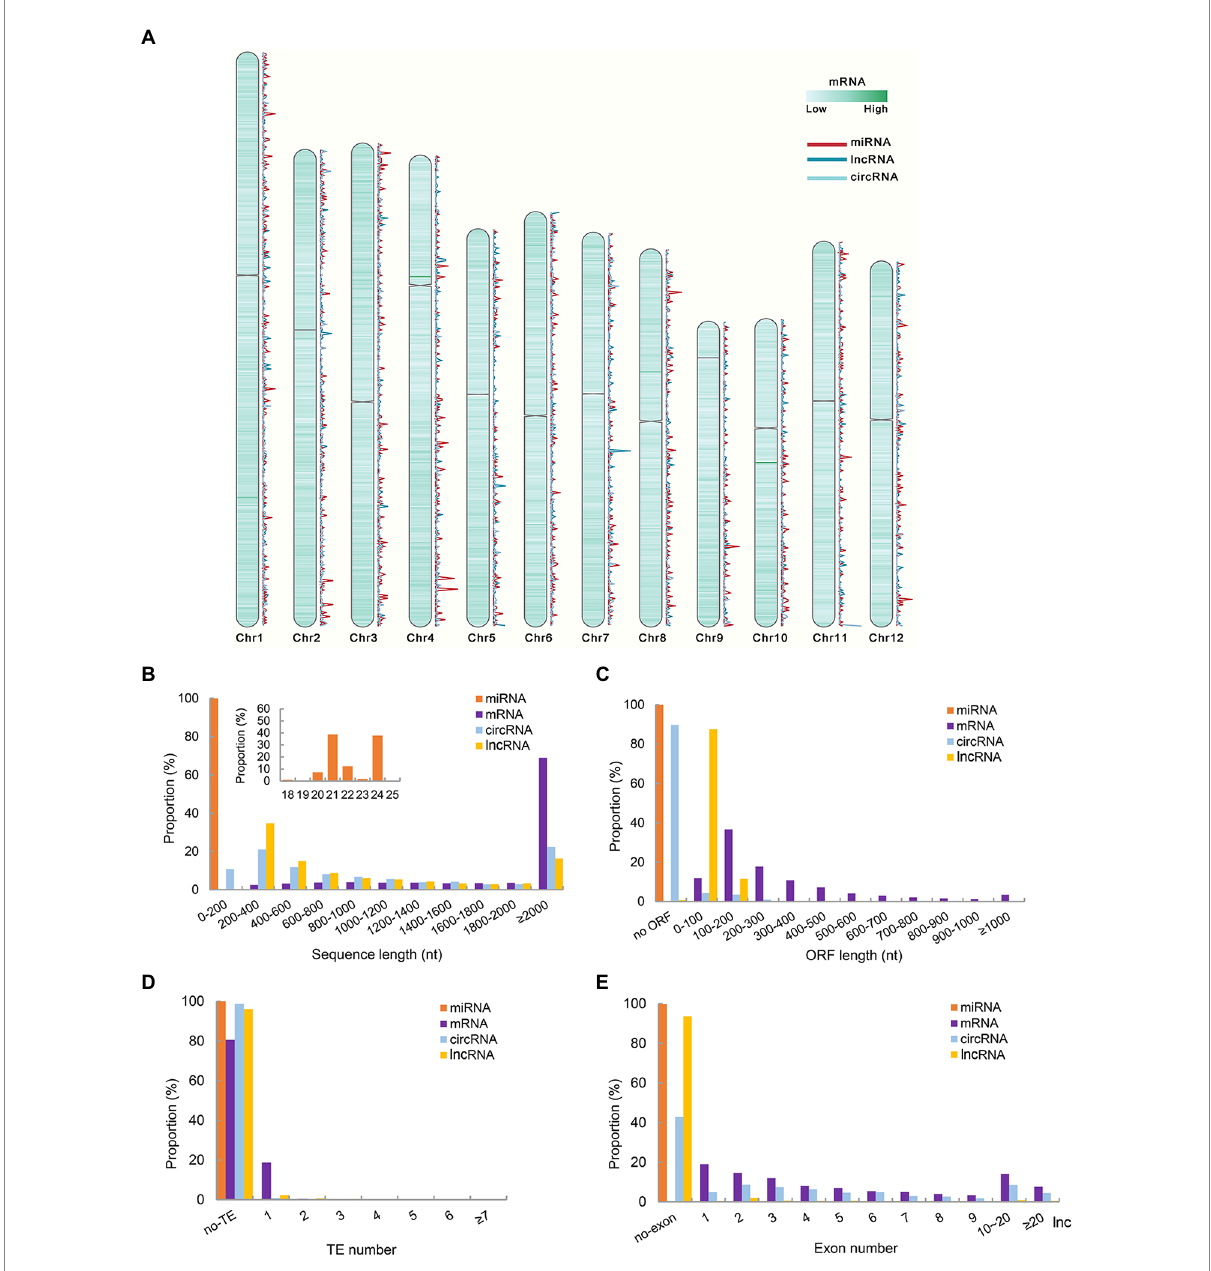
FIGURE 1 Genomic characteristics and structure characteristics of all identified RNAs corresponding genes. (A) Density map of mRNA, miRNA, lncRNA and circRNA corresponding genes on different chromosomes. (B) Sequence length of identified ncRNAs and mRNAs. (C) Corresponding DNA sequence ORF length of identified ncRNAs and mRNAs. (D) The number of TE contained in the corresponding DNA sequence of ncRNAs and mRNAs. (E) The number of Exon contained in the corresponding DNA sequence identified ncRNAs and